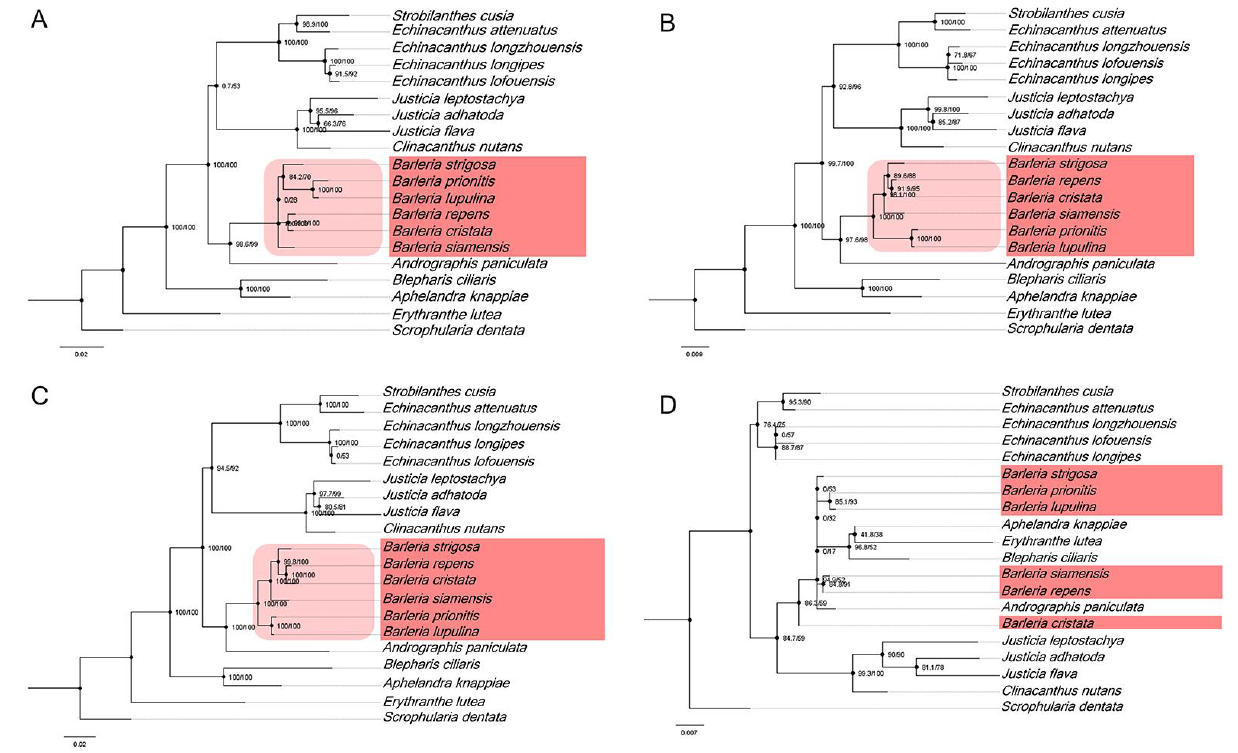
Figure 7. Phylogenetic relationships from four nucleotide hotspot regions, including ( A ) ccs A- ndh D, ( B ) ndh A- ndh H- rps 15, ( C ) ycf 1, and ( D ) trn N-GUU- trn R-ACG. The numbers associated with each node represent bootstrap support values.